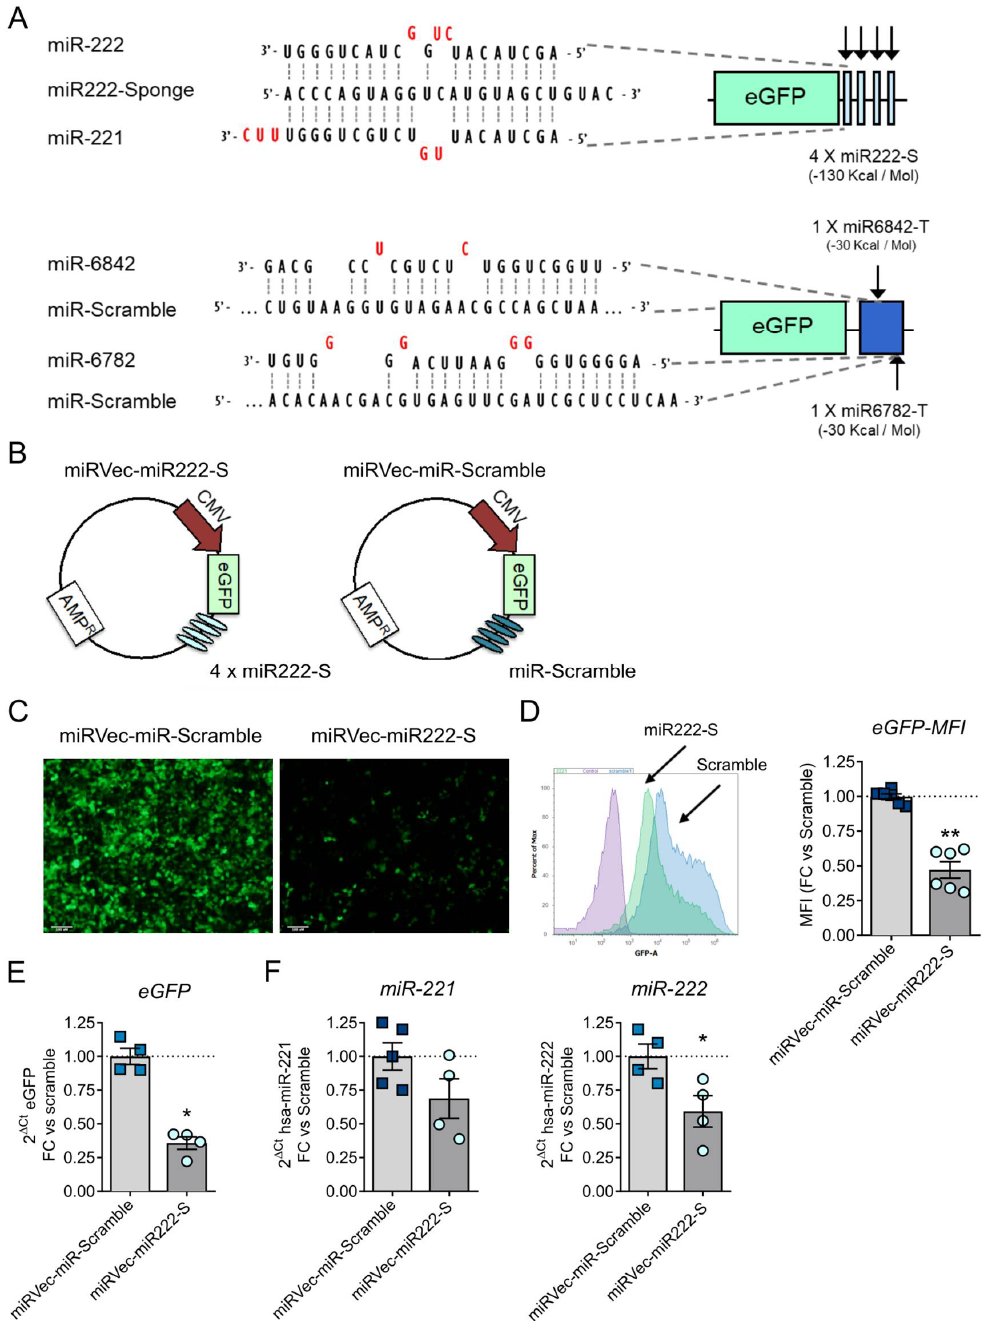
Figure 3. Generation and functional validation of miR-222 sponge in miRVec-eGFP-miR222-S and miRVec-eGFP-Scramble. ( A ). Scheme of the sponge design with a sequence alignment of miR-222, miR-221, and the sponge (upper figure). A representation of the Scramble sequence with predictive off-targets miRNAs is also provided (lower figure). ( B) . Schematic representation of miRVec-eGFP-miR222-S and miRVec-eGFP-Scramble constructs. ( C – F ). Expression of eGFP from HEK-293T cells transfected with miRVec-eGFP-miR222-S or miRVec-eGFP-Scramble. ( C ). Representative images of eGFP fluorescence (scalebar 100 µm). ( D ). eGFP quantification by flow cytometry. The left panel shows a representative plot. The right panel shows the quantification of mean fluorescence intensity (MFI). ( E ). eGFP quantification by qRT-PCR. ( F ). Quantification of miR-221 and miR-222 content in HEK-293T cells transfected with miRVec-eGFP-miR222-S and miRVec-eGFP-Scramble. Values are represented as fold change compared to the Scramble construct. Data are shown as mean ± SEM for at least four independent biological replicates. Significance was assessed using a two-tailed Mann–Whitney test. * p < 0.05, ** p <